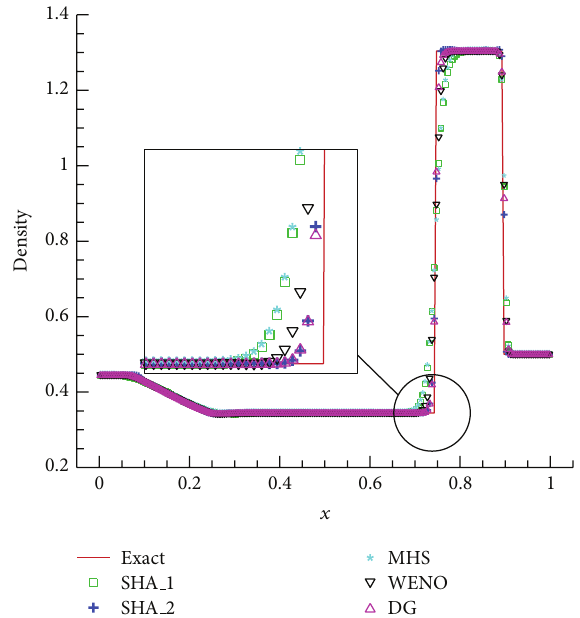
Figure 17: Velocity comparison of schemes at time 0.16 units for Lax problem.